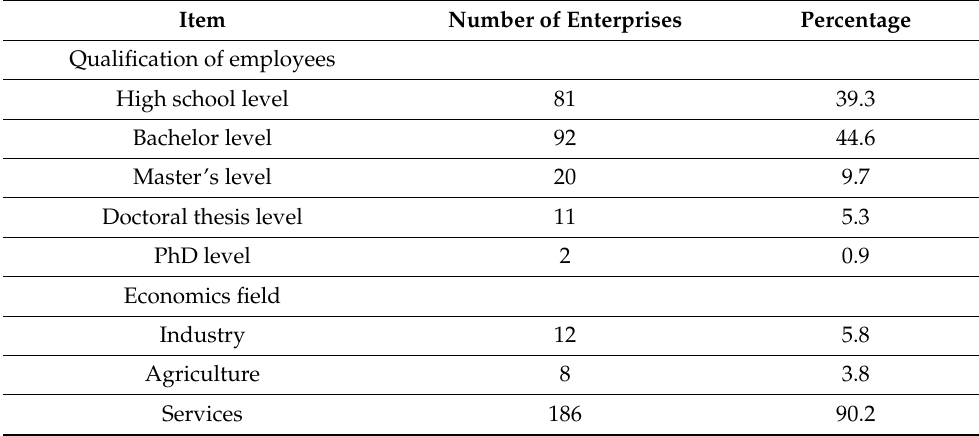
Table 1. Data from a survey of SMEs’